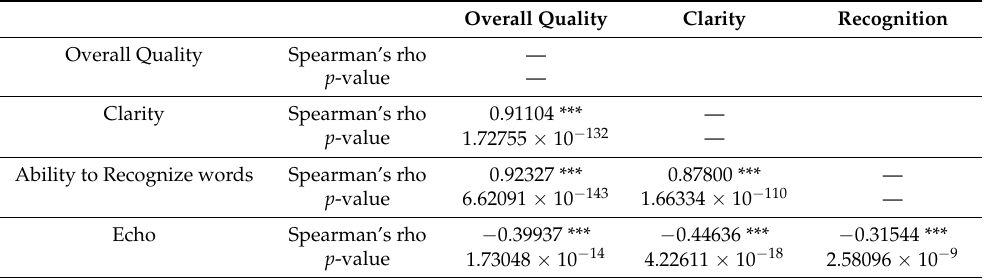
Table 3. Spearman’s correlation between 4 survey parameters.